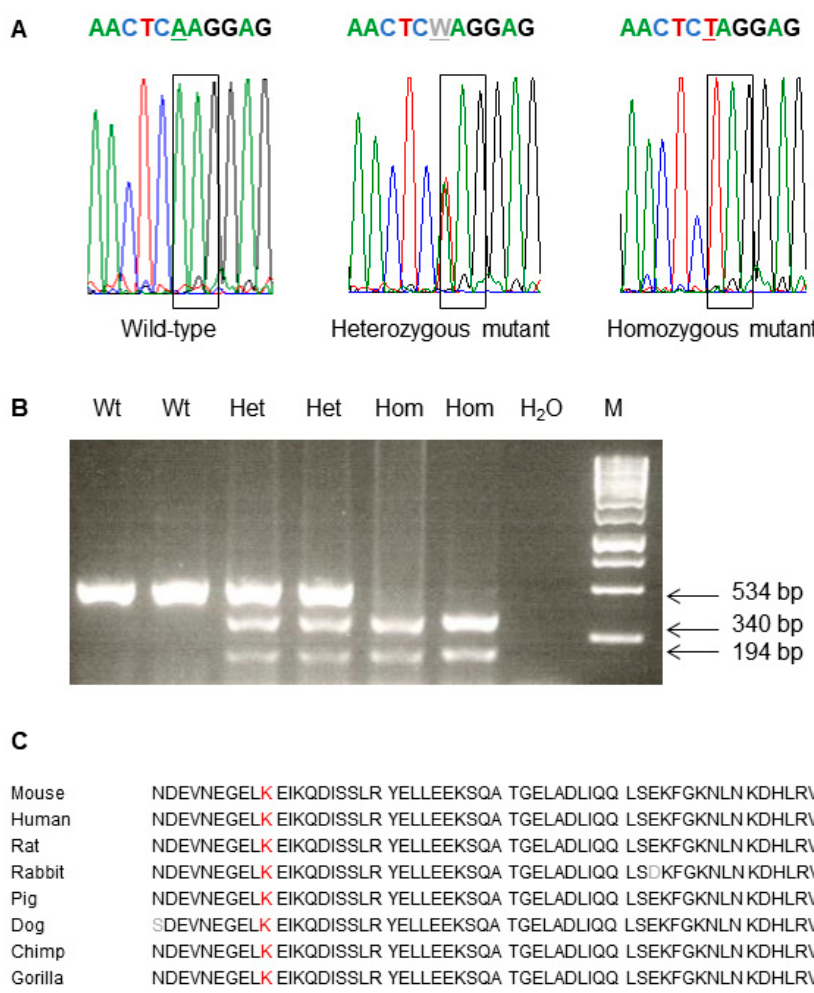
Figure 2. Analysis of the causative point mutation in mutant and wild-type mice of line Trpc7 K810Stop . ( A ) Electropherogram of the causative point mutation. The box shows the AAG → TAG